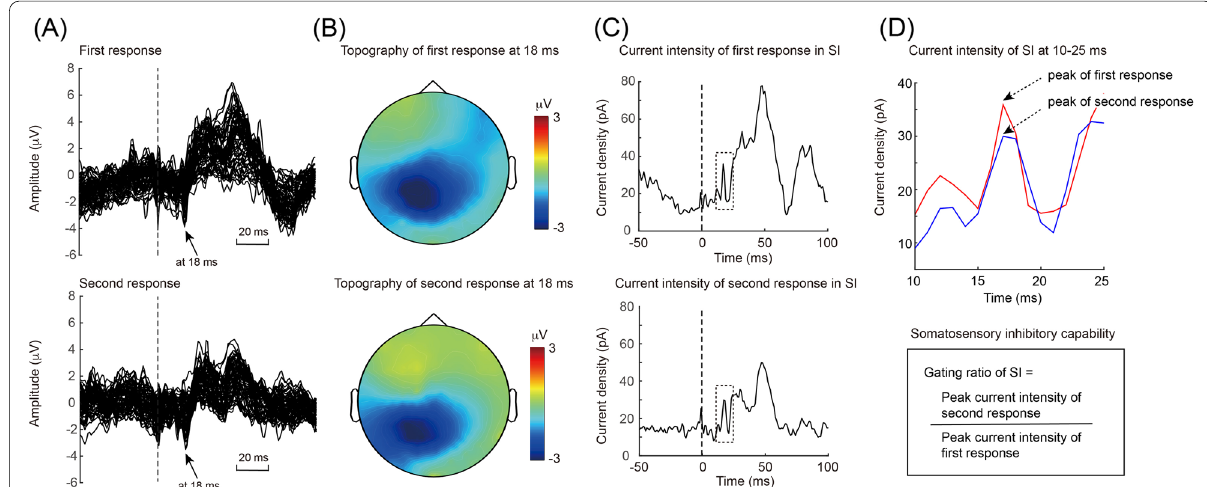
Fig. 7 SSEPs for paired‑pulse stimulation. A Superimposed SSEPs (first and second responses) peaked at 18 ms in response to paired electrical stimulation. B Topographies of peak first and second responses. C S1 current intensity over time for first and second responses. Dashed square indicates peak S1 component. D Acquisition and calculation of S1 gating ratio (inhibitory capability). S1, primary somatosensory cortex